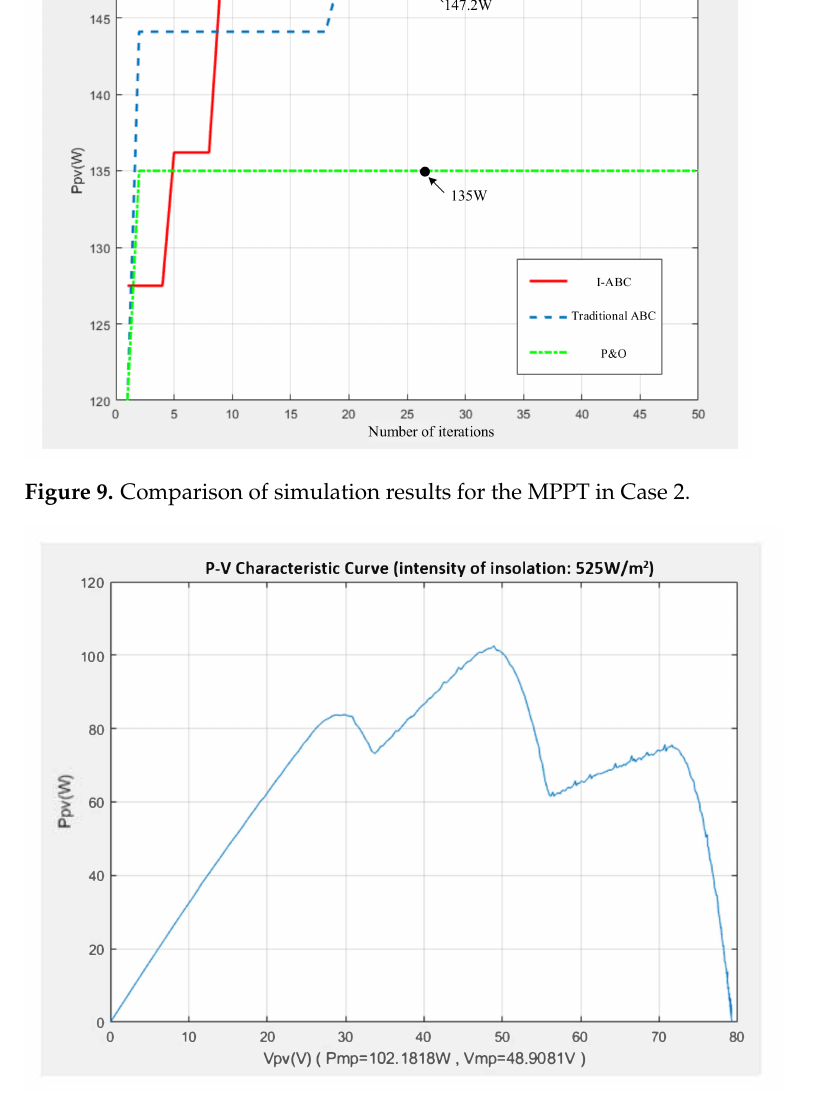
Figure 10. P-V characteristic curve of photovoltaic module array in Case 3 (with triple-peak values). Figure 12 shows the P-V characteristic curve of the photovoltaic module array under insolation intensity as 534 W/m 2 and three modules shaded 30%, 50%, and 70%, respec- tively, in Case 4, wherein quadruple-peak values were presented and the real MPP P mp was 83.84 W. According to the simulation results of the three tracking methods shown in Figure 13, it was observed that the I-ABC algorithm could track the GMPP ( P mp = 83.8 W) with only 5 iterations, but 25 for the traditional ABC algorithm. As per the P&O method, the initial tracking voltage was near the point at the valley area where the GMPP was located, so the GMPP could be tracked smoothly but more iterations are